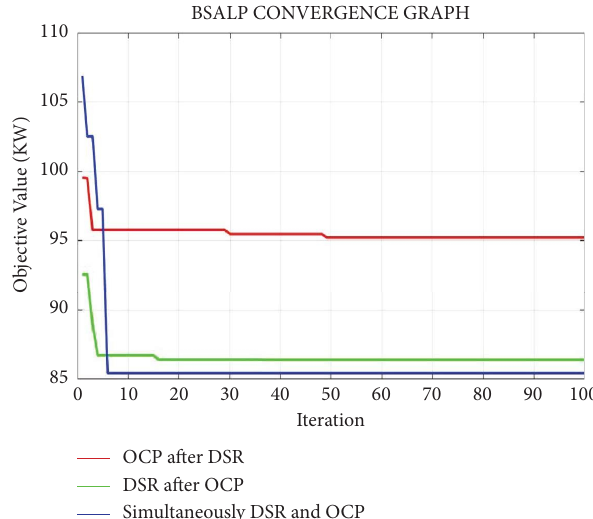
Figure 20: Convergence active power losses (kW) for 69-bus using the suggested BSSA